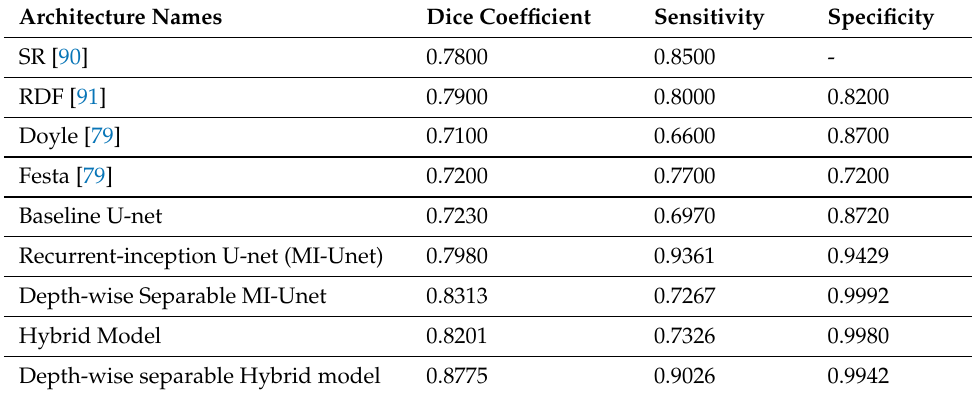
Table 7. Performance Comparison with state-of-the-art